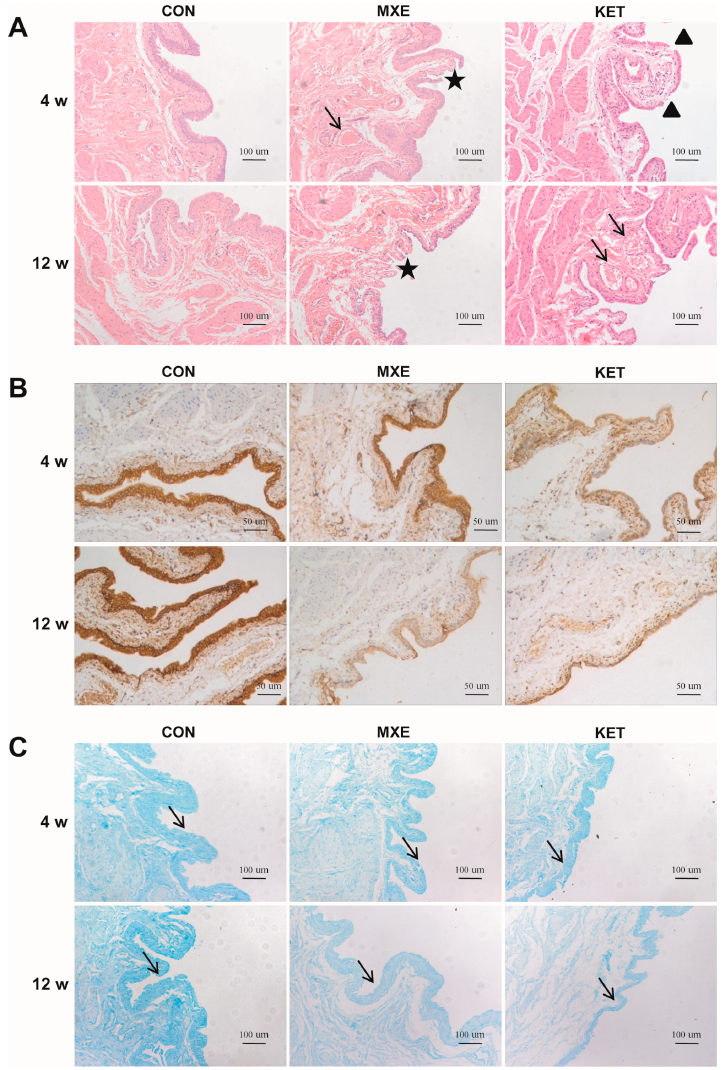
Figure 4. Mucosal injury in rat bladder tissue after MXE and KET administration. ( A ) Methoxetamine- treated rats showed mild tissue congestion (arrow) and interrupted continuity of mucosa (asterisks). Magnification: ×100, scale bar: 10 μ m. The bladder tissues of ketamine-treated rats were characterized by mucosal laceration (triangles), papillary protrusions, and erythrocyte accumulation (arrows);